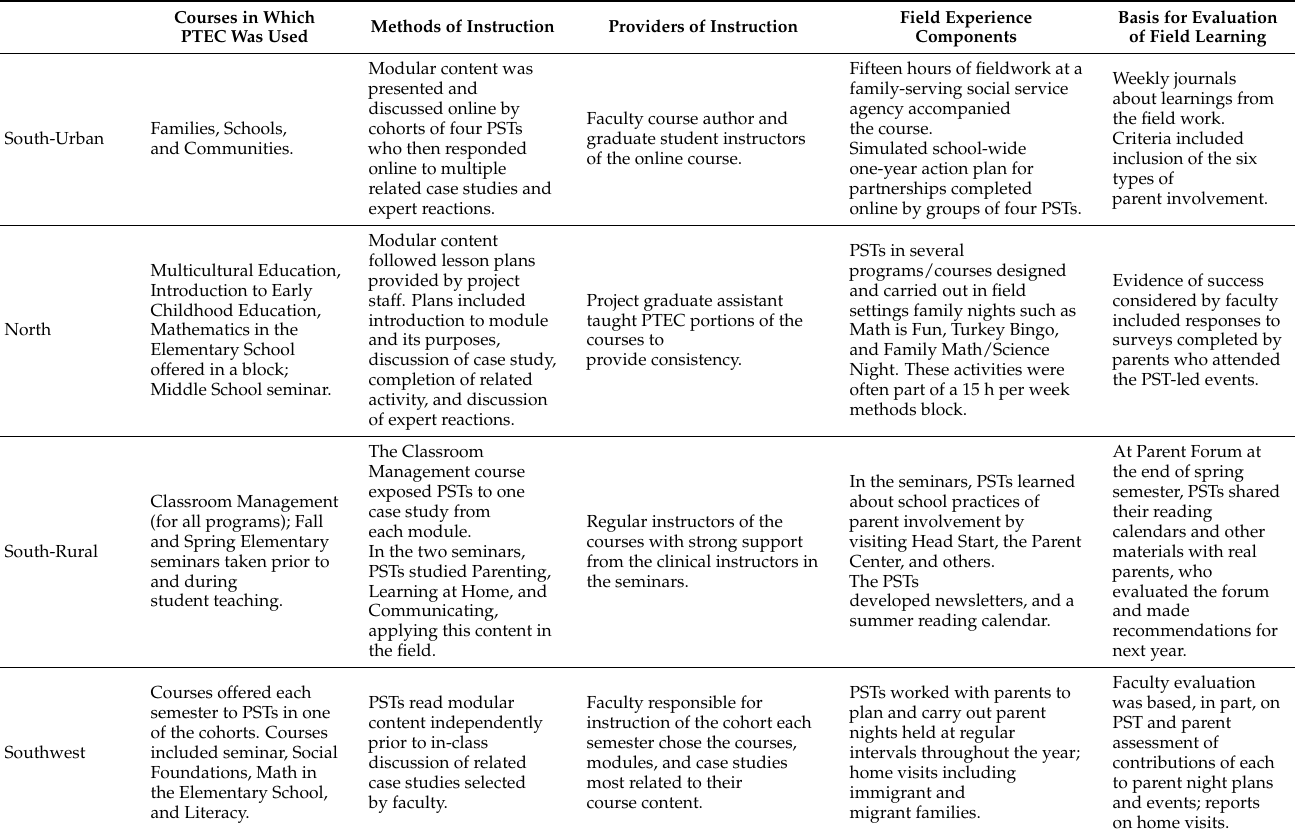
Table 2. PTEC implementation at each